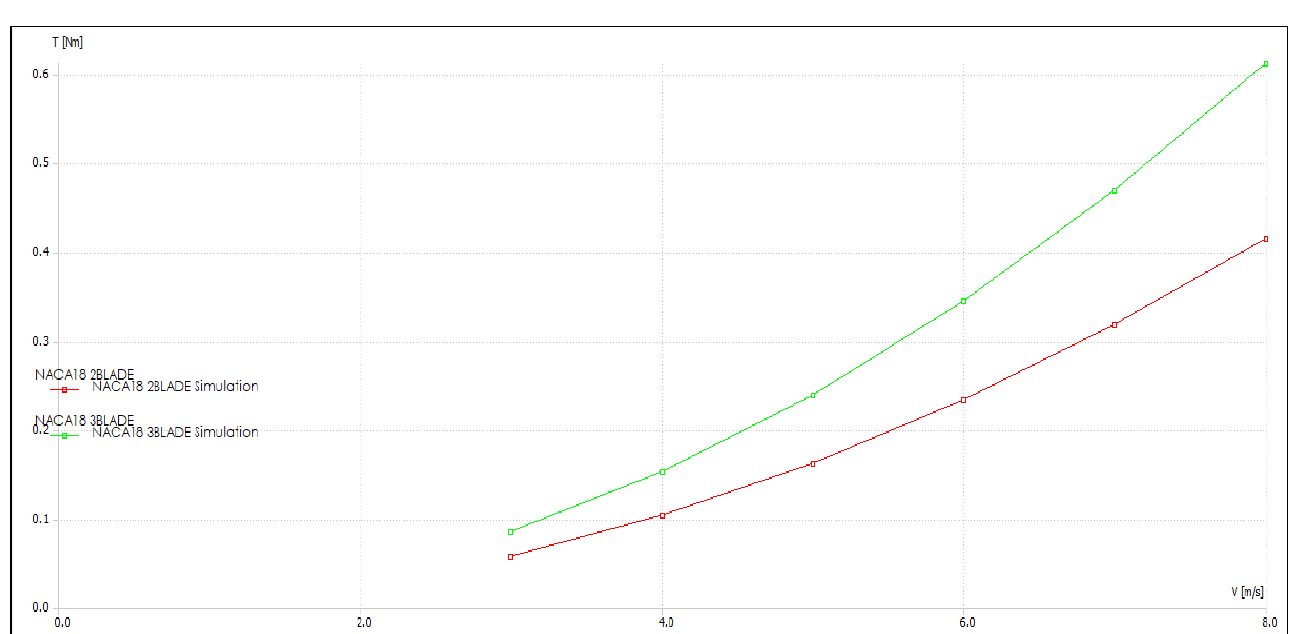
Figure 45. Torque vs wind